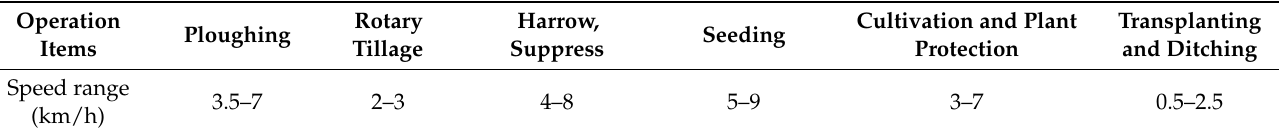
Table 1. Theoretical working speed for the main operation of the crawler